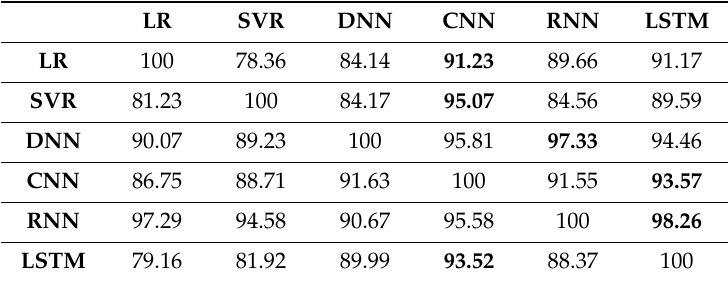
Table 3. Transferability of adversarial samples from one model to another model.